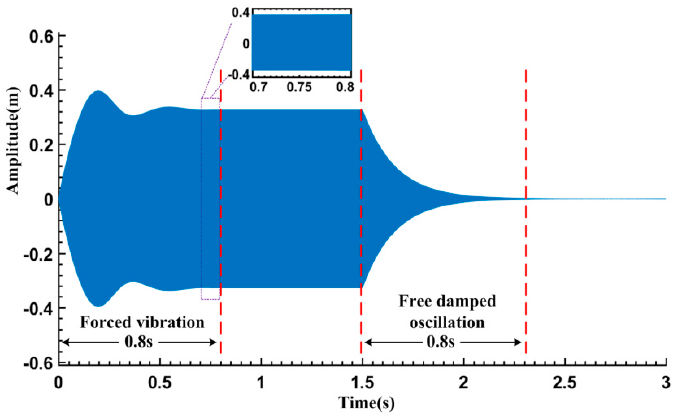
Figure 1. Typical response of the simulated Duffing system.